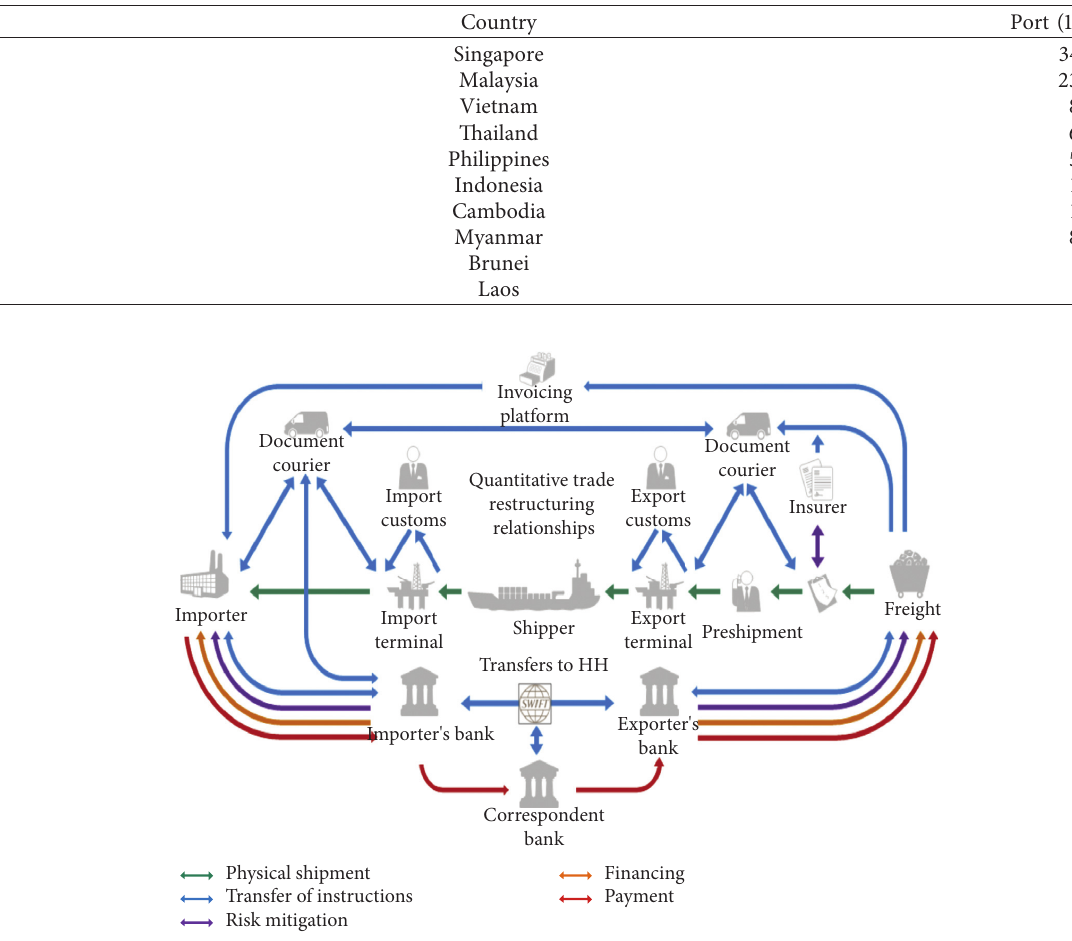
Figure 2: Quantitative trade restructuring relationships.